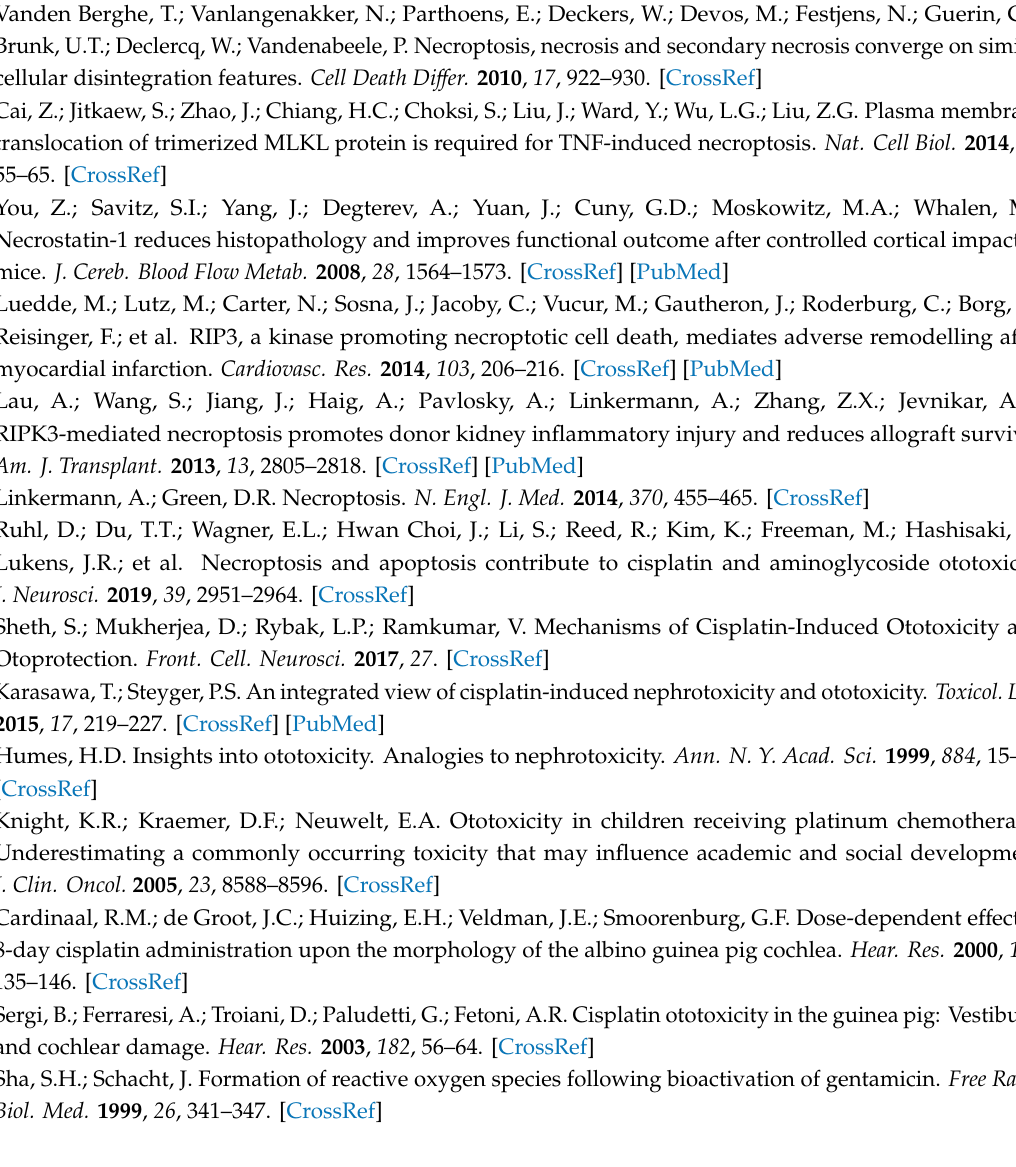
Figure S1: Western blot of whole cochlear